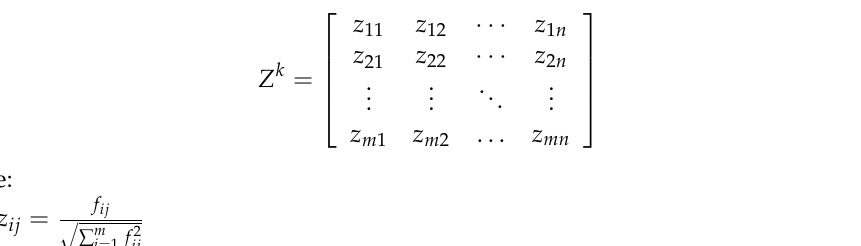
Table 3. Linguistic and numeric scale for TOPSIS. Linguistic Value Numerical Value Very Low 1 Low 3 Moderate 5 High 7 Very High